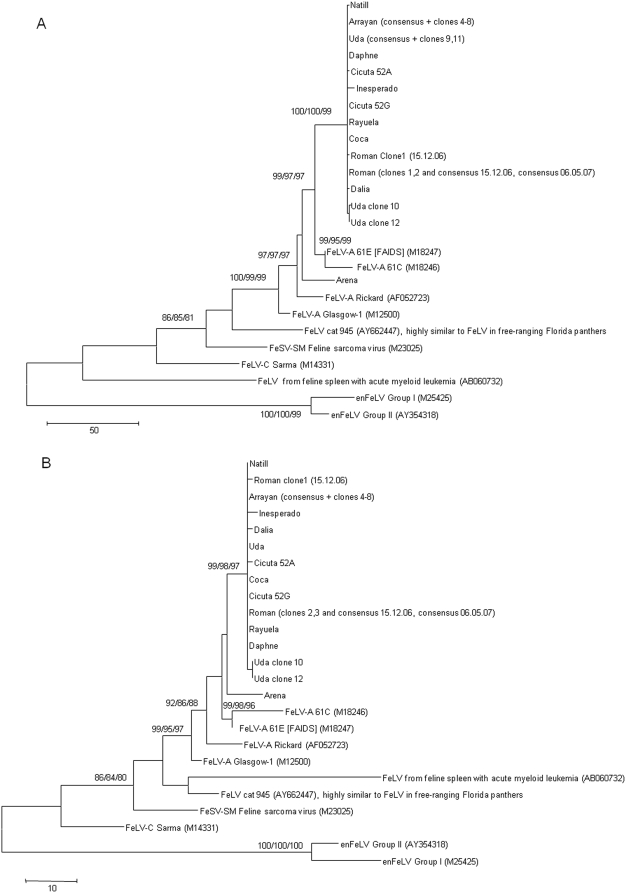
Evolutionary relationships of Iberian lynx FeLV SU.The Maximum Parsimony (MP) tree is shown. Trees are drawn to scale; length is in terms of the number of changes over the entire sequence. (A) Relationships at the DNA level. MP tree length = 643, consistency index = (0.744726), retention index = (0.827143), composite index = 0.671491 (0.615995) for all sites and parsimony-informative sites (in parentheses). The codon positions included were 1st+2nd+3rd+Noncoding. There were a total of 1424 base positions in the final dataset, of which 311 were parsimony-informative. (B) Relationships at the protein level. MP tree length = 253, consistency index = (0.861538), retention index = (0.876712), composite index = 0.783150 (0.755321) for all sites and parsimony-informative sites (in parentheses). There were a total of 473 amino acid positions in the final dataset, of which 108 were parsimony informative.